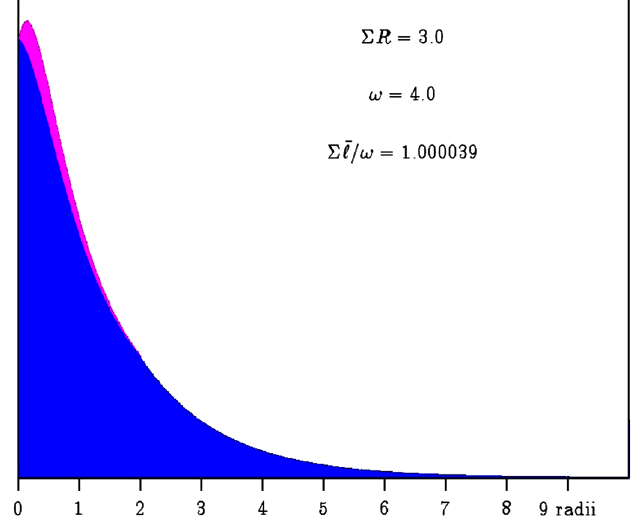
Fig. 5. Distribution of the lengths travelled by the particles for a sphere of opacity